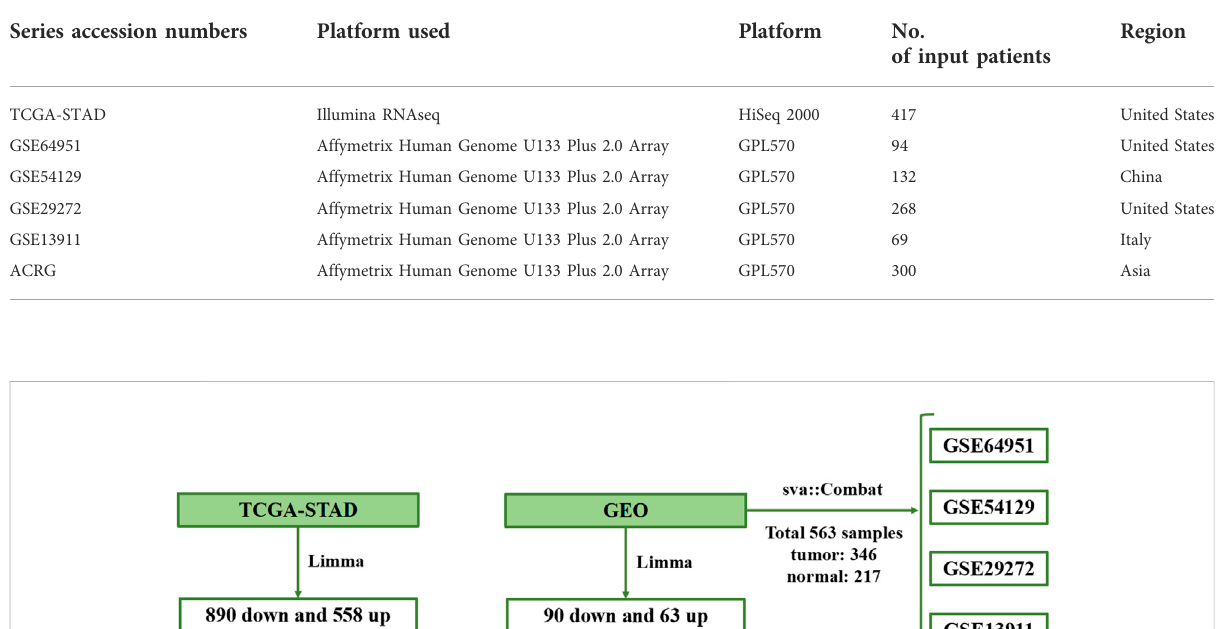
TABLE 1 Basic information regarding the series used in the study.